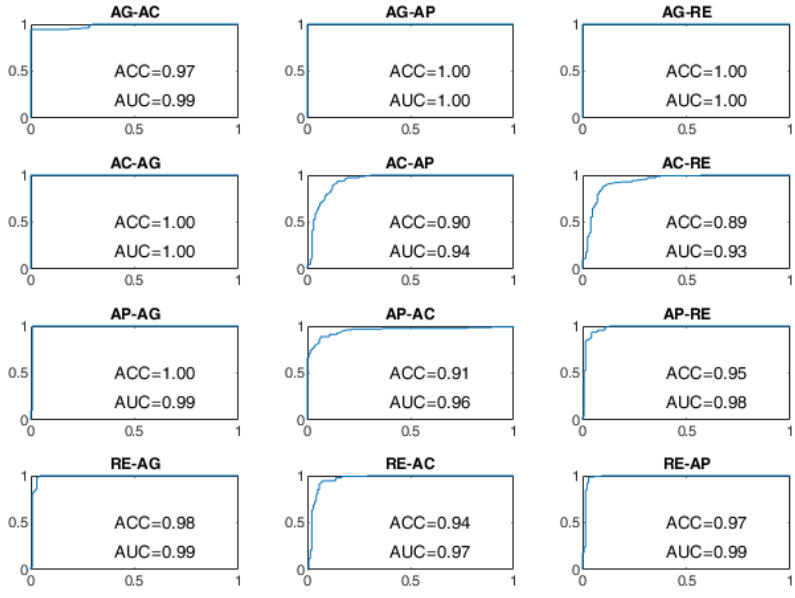
Figure 9 . ROC curves of the OCSVM approach on the DS1 dataset for WD = 70 s.